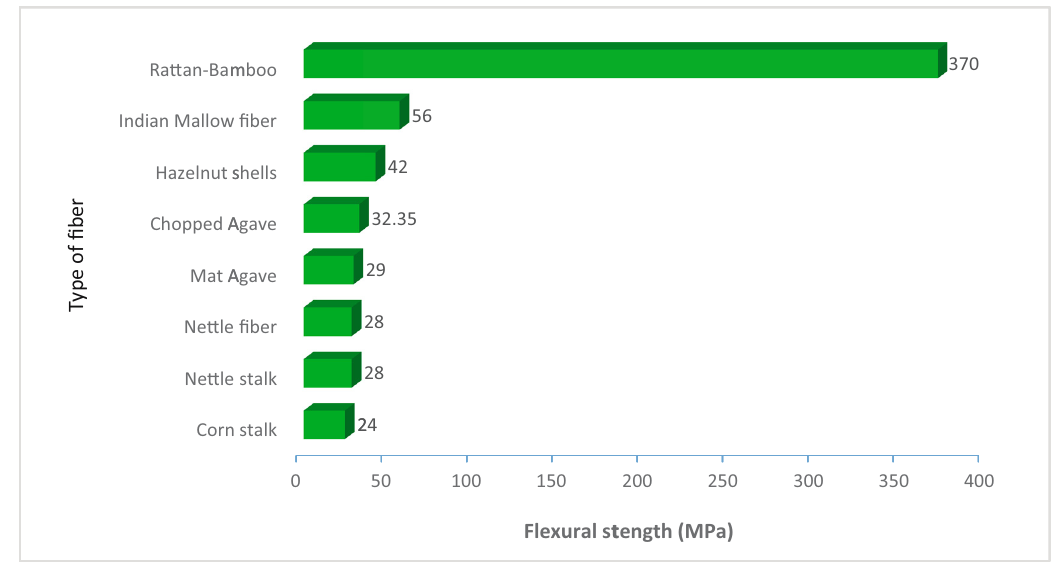
Figure 5: FS values of polyester at 20 wt% of di ff erent natural fi